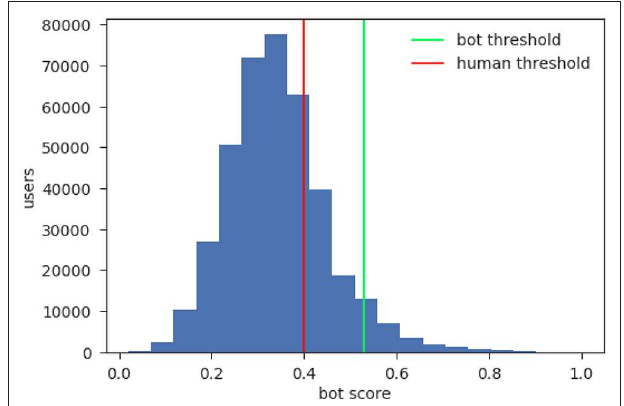
FIGURE 1 | Frequency distribution of the bot scores obtained with Botometer. We plot the number of accounts in the FE dataset according to their Botometer score. We classified as bots the 5% top scoring accounts, corresponding to a minimum value of 0.53 (green line). We set instead 0.4 (red line) as a maximum threshold value for the labeling of a human. Both choices are informed by previous analyses and intended to reduce the risk of misclassifications